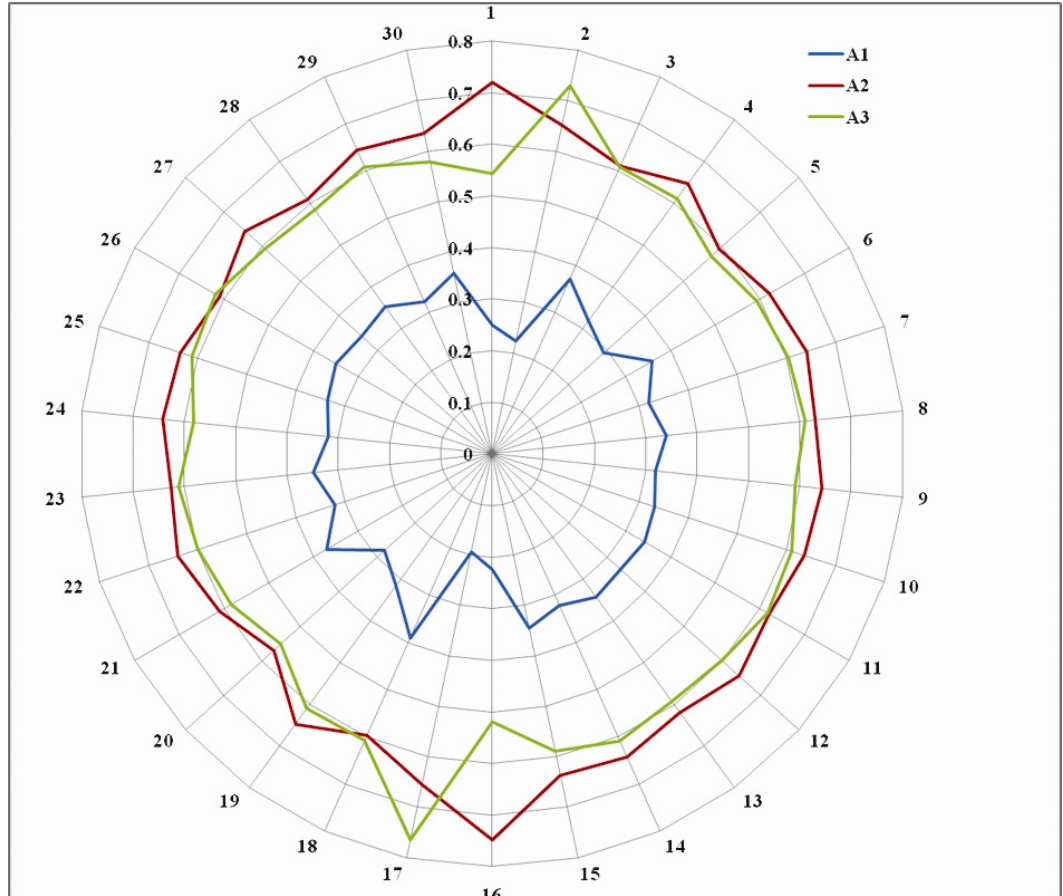
Fig. 8. Sensitivity